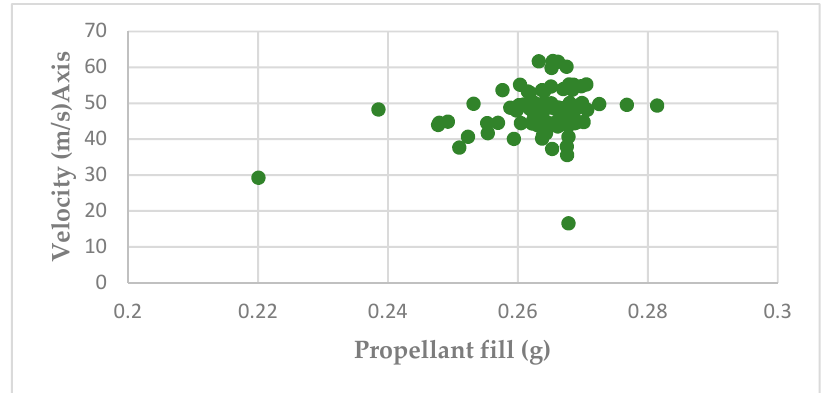
Figure 13. A scattergram of the relationship between propellant fill (g) and velocity (m/s) using 100 Green 3.00 grain cartridges.